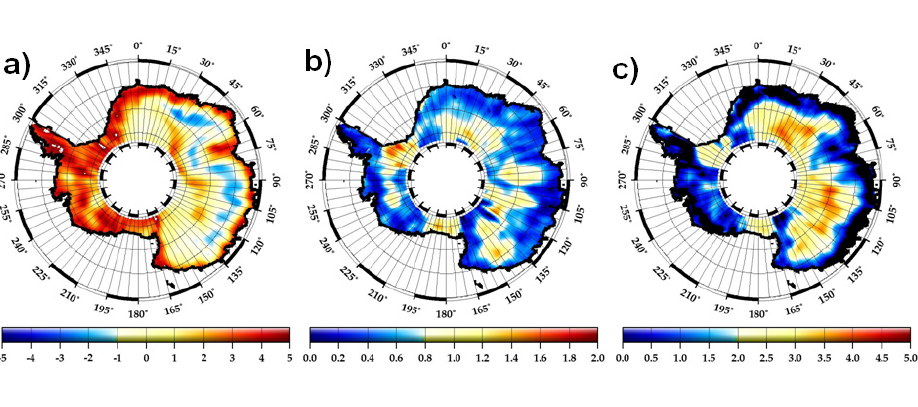
Figure 5. Difference in the altimetric waveform parameters between the Ku-band and the S-band, from the Envisat altimeter. (a) The backscattering coefficient expressed in dB, (b) the leading edge width expressed in meters, (c) the trailing edge slope expressed in 10 6 s − 1